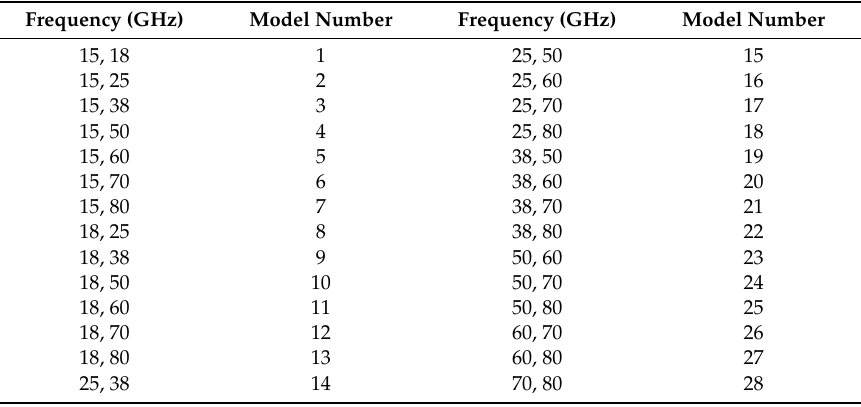
Table 3. Model numbers of dual-frequency